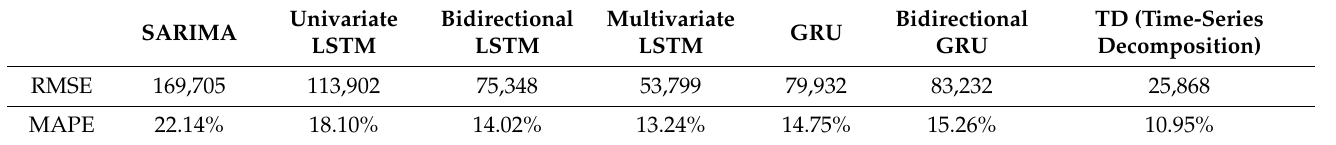
Table 6. Comparison of RMSE and MAPE for deep learning